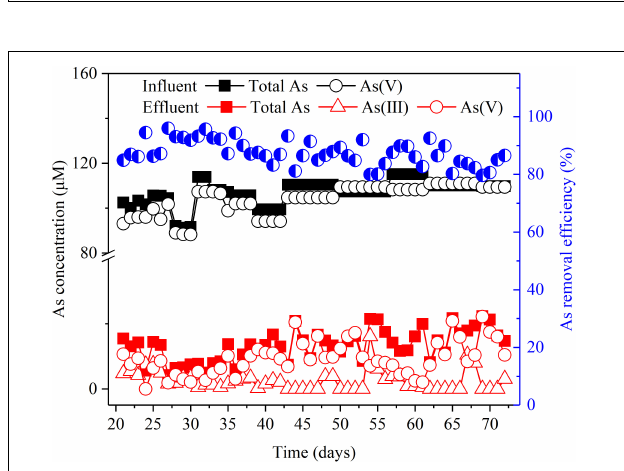
FIGURE 2 | As removal in the BES cathode chamber. The left Y -axis indicates the concentrations of total As, As(V), and As(III) in the influent and the effluent, and the right Y- axis indicates total As removal efficiency in the effluent. Experimental conditions: influent [As(V)] = 100 µ M, (Na 2 SO 4 ) = 3.3 mM, I cell = 30